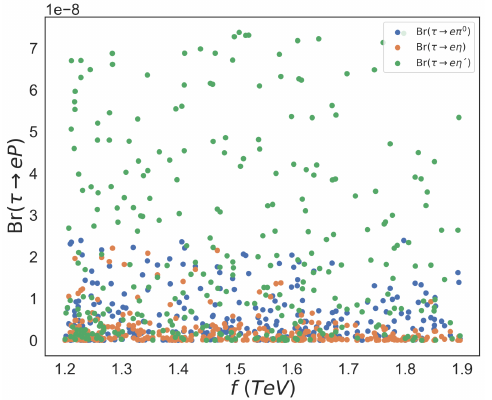
Figure 9 . Scatter plot f vs. Br( τ → ePP ) without Majorana neutrinos contribution.